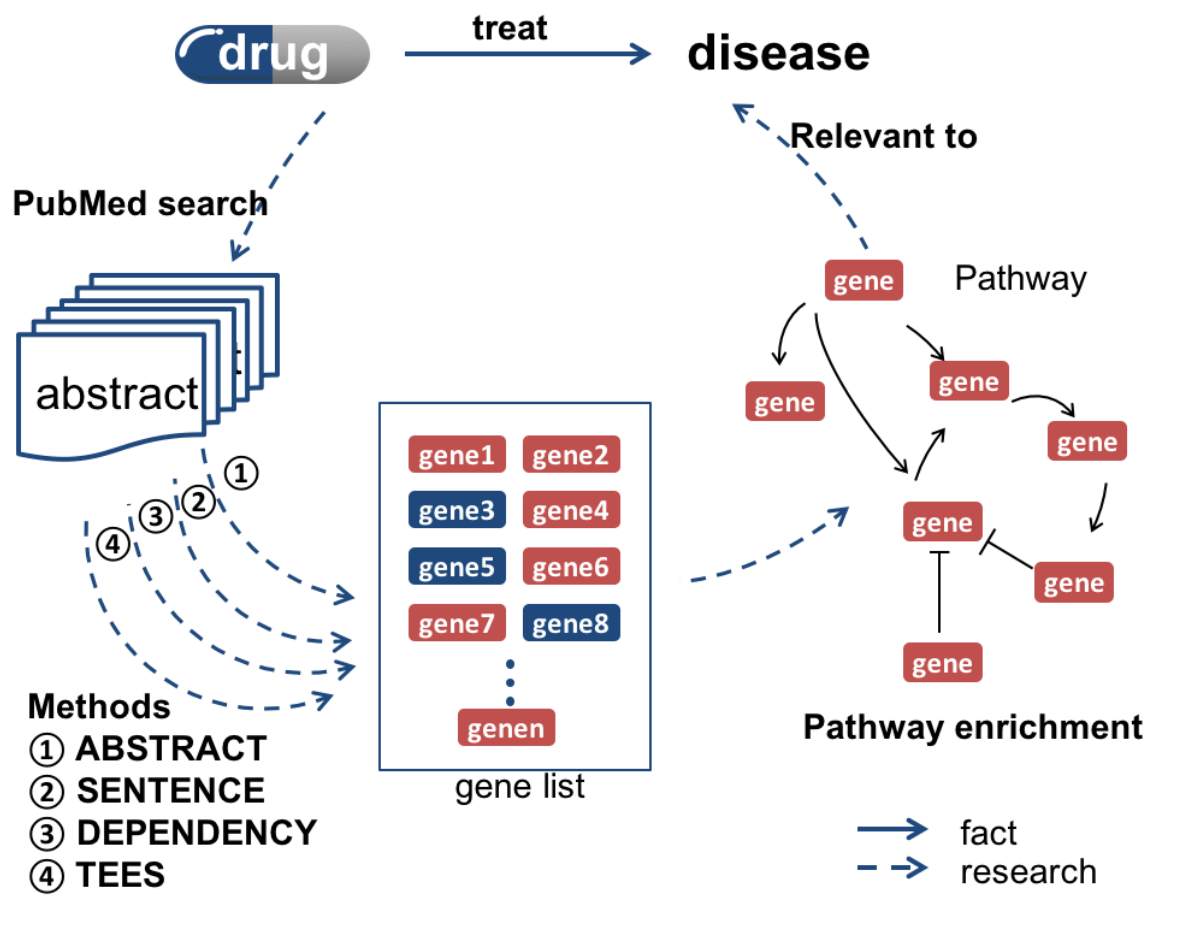
3. Method 3: DEPENDENCY. Being stricter than sentence-level gene-pair extraction, the syntactic rule was introduced to restrict the co-occurrence filtering rule. Here, the Stanford parser was used to identity the gene subject or the gene object in a sentence. The gene pair is maintained only when the 2 genes act as sub or obj in the syntactic tree. 4. Method 4: TEES. TEES [20] is a sophisticated biomedical relation extraction system, which has been trained over 400,000 linguistics features. TEES is used to extract the genes that have interactions with other genes in drug-related abstracts. Thus, the TEES method provides a set of genes, which shows interaction information in drug-related